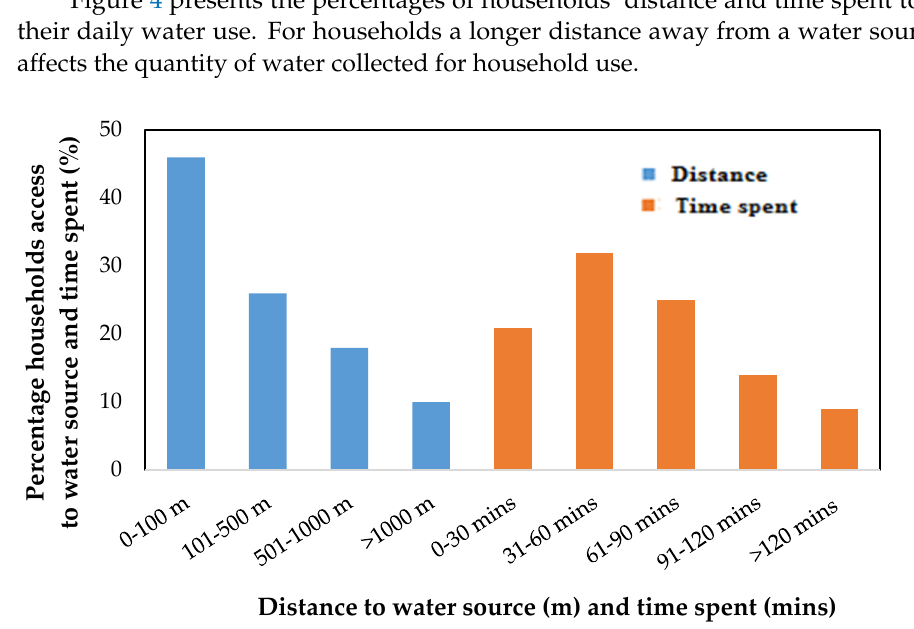
Table 3. Percentages of households with multiple water sources at various distances.